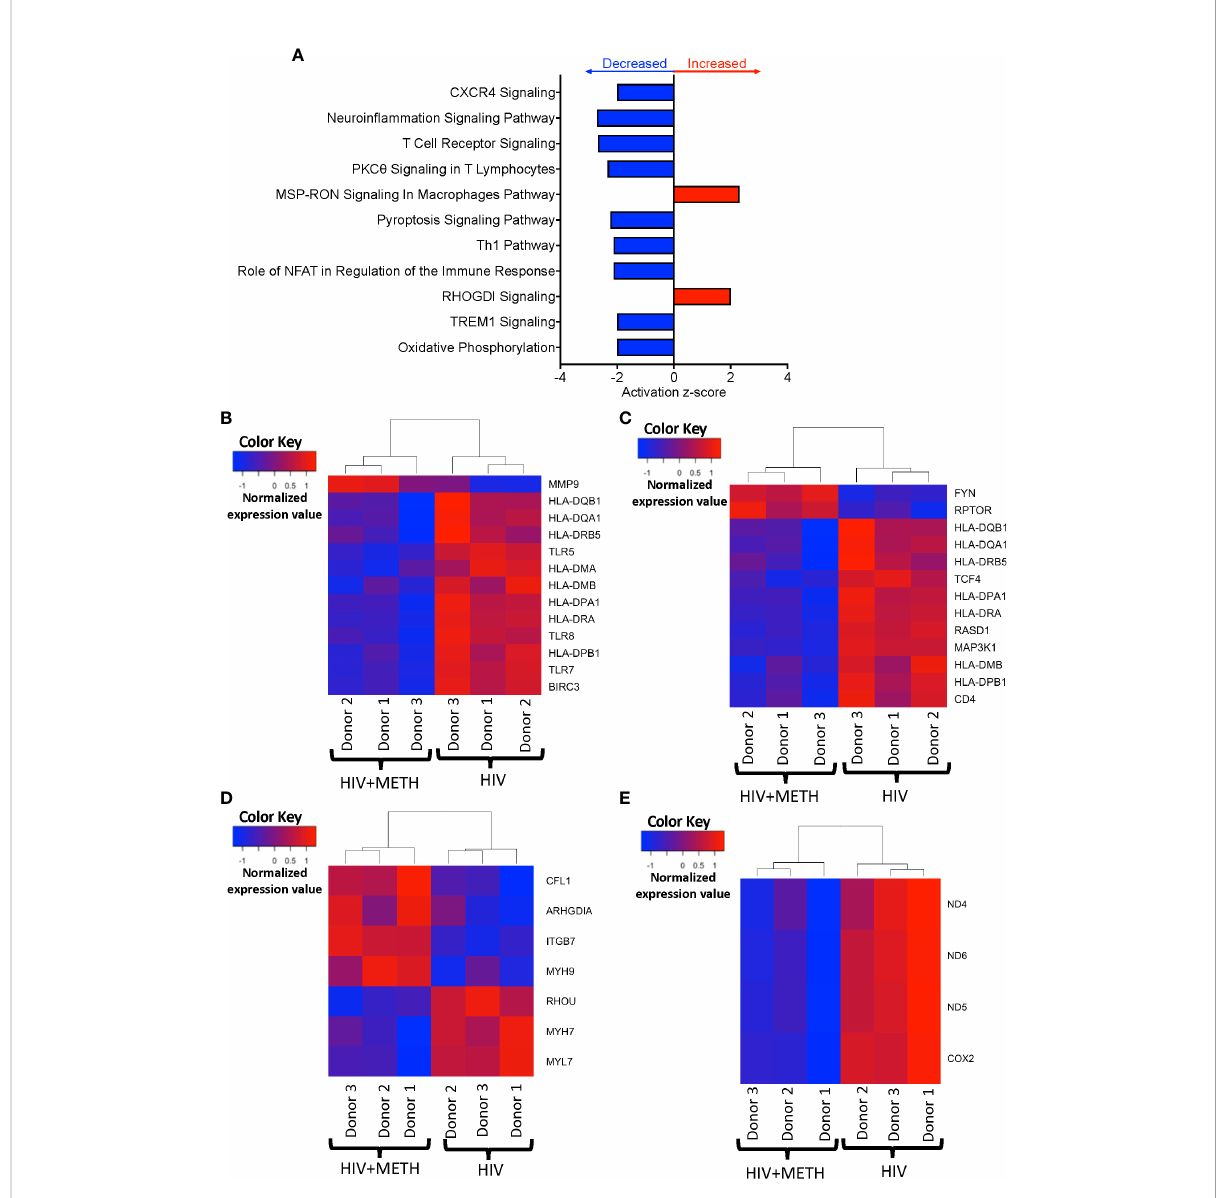
FIGURE 3 HIV-infected mature monocytes treated with meth have decreased expression of genes related to antigen presentation, pathogen recognition, and oxidative phosphorylation, and upregulation of genes related to cellular RHO-GD1 signaling pathways. (A) Top cellular pathways predicted to be increased (red) or decreased (blue) in meth treated compared to untreated HIV-infected cells. The y-axis represents the list of pathways, and the x-axis represents activation z-score. (B – E) Heat maps representing normalized expression levels of some genes involved in (B) neuroin fl ammation signaling pathways, (C) T-cell receptor signaling, (D) oxidative phosphorylation, and (E) RHO-GDI signaling in HIV-infected mature monocytes treated, or not, with meth. Each column represents an individual sample, and each row represents a gene. The color scale represents lower (blue) to higher (red) gene expression levels. The dendrograms show unsupervised clustering of